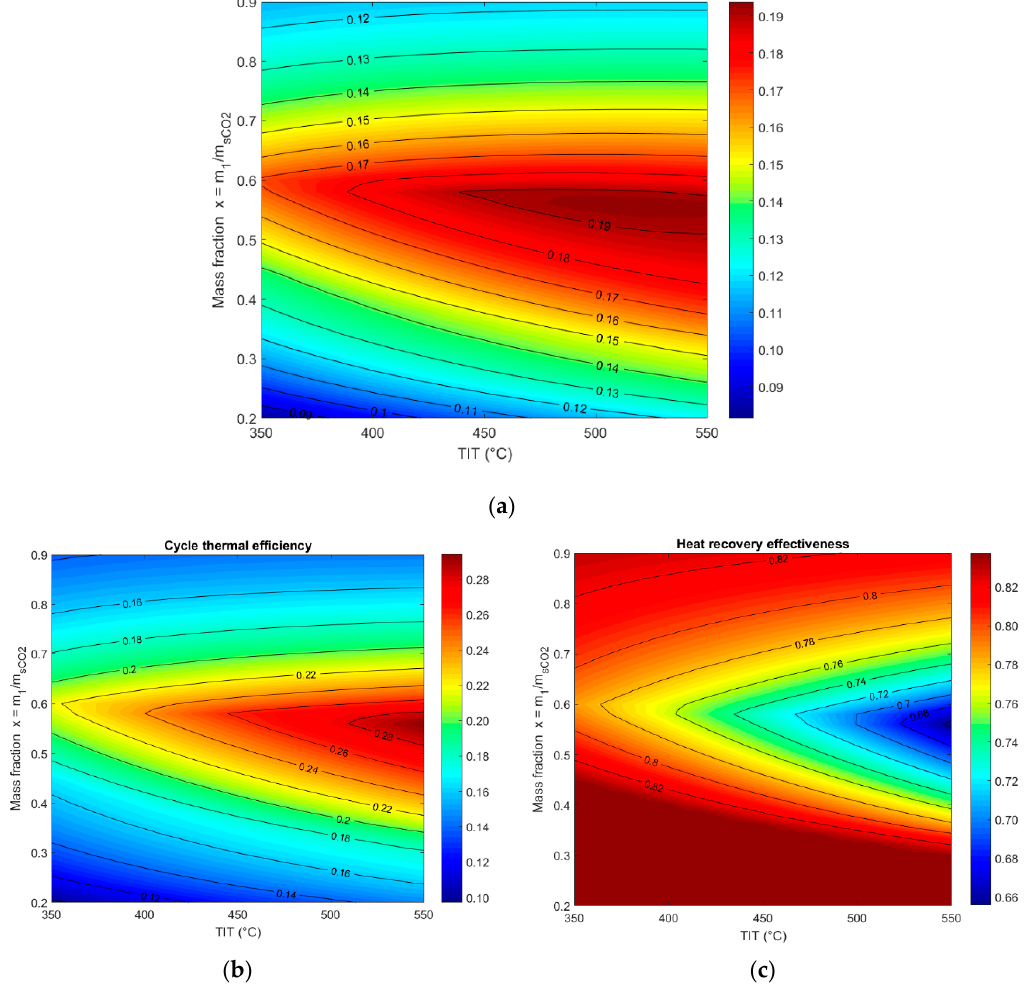
Figure 13. Variation of the performance metrics with TIT and x for the dual recuperated cycle: ( a ) Total heat recovery efficiency; ( b ) cycle thermal efficiency; ( c ) heat recovery effectiveness.